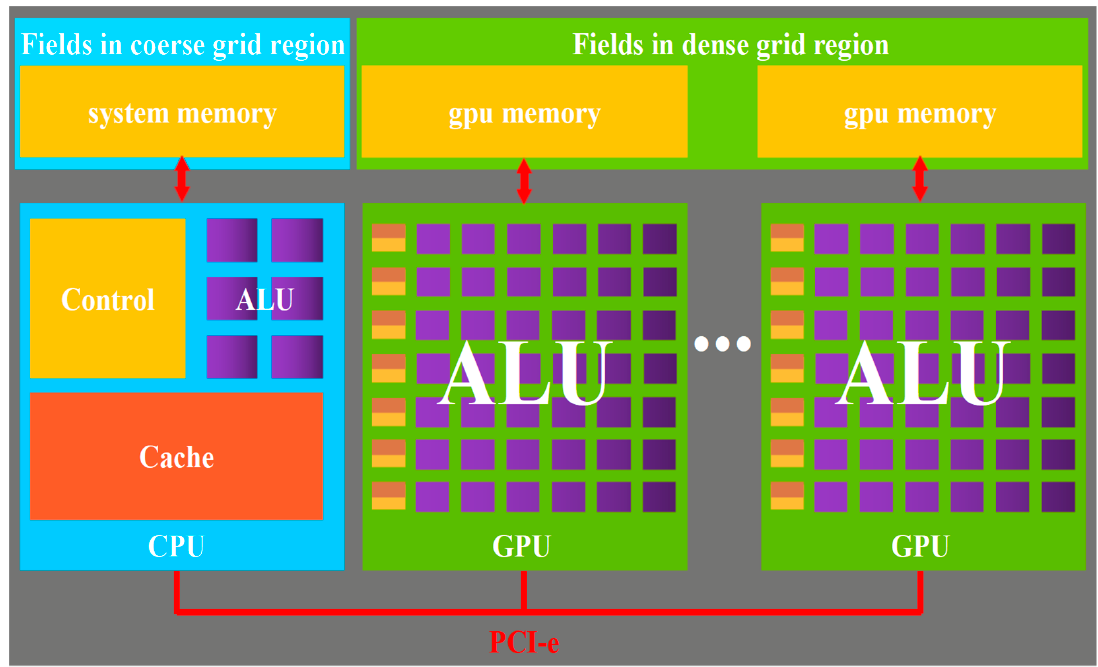
Figure 4. Heterogeneous computing platform.